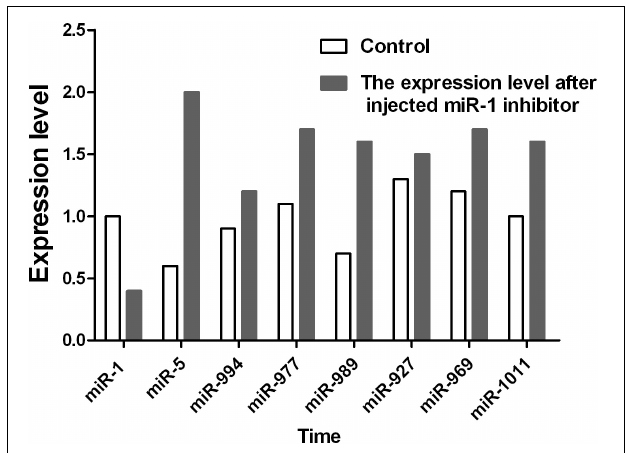
FIGURE 12 | The expression level of the miR-1 cluster was detected by RT-PCR when miR-1 was